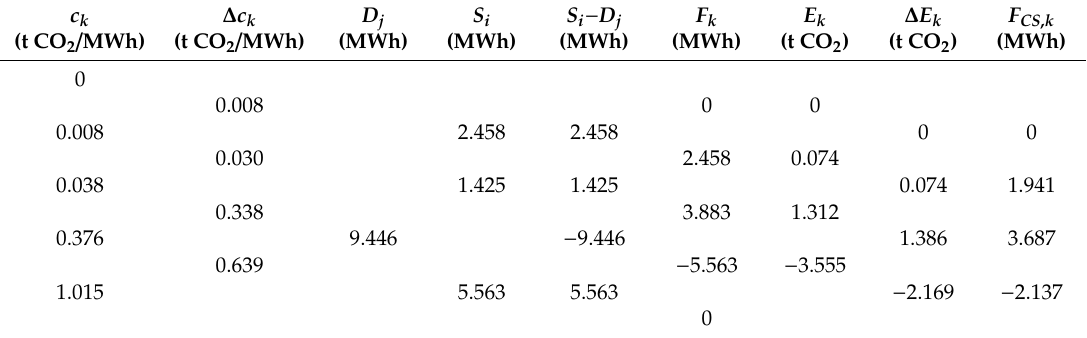
Table 3. Cascade analysis for zero-carbon energy source where not all CO 2 loads are non-negative.